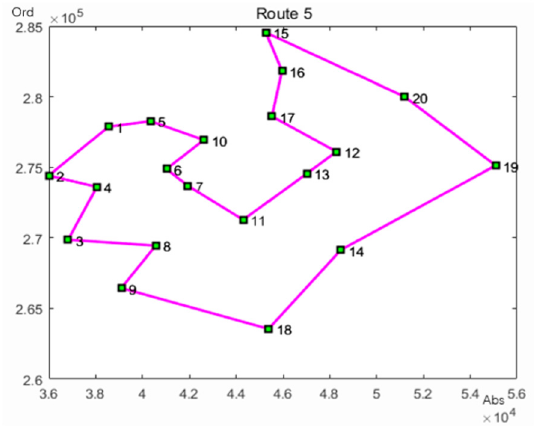
Figure 6. Delivery order of fifth courier.